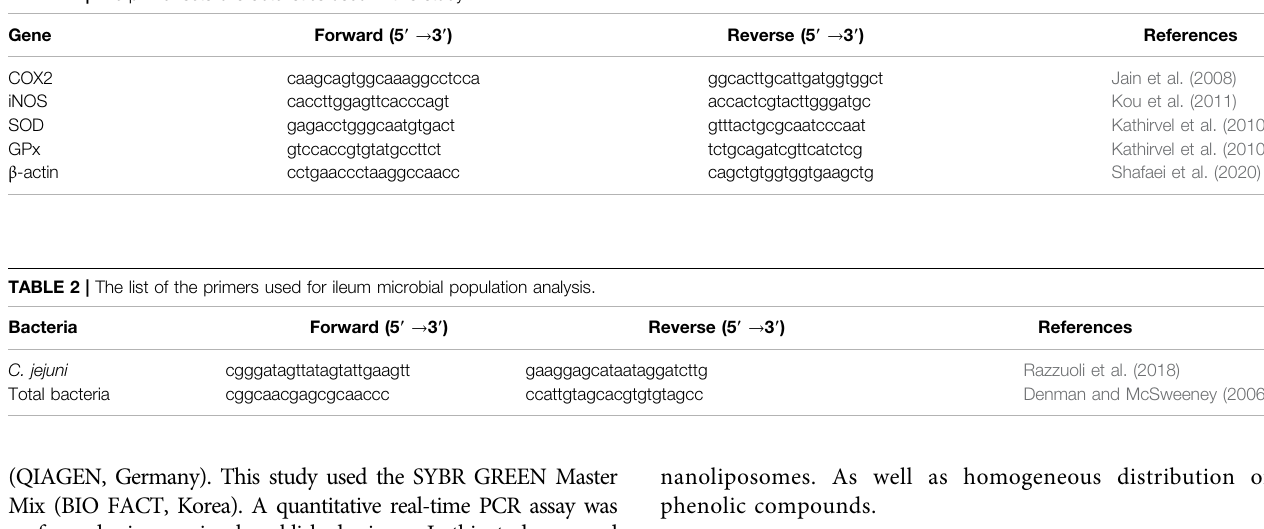
TABLE 1 | The primer sets characteristics used in this study.